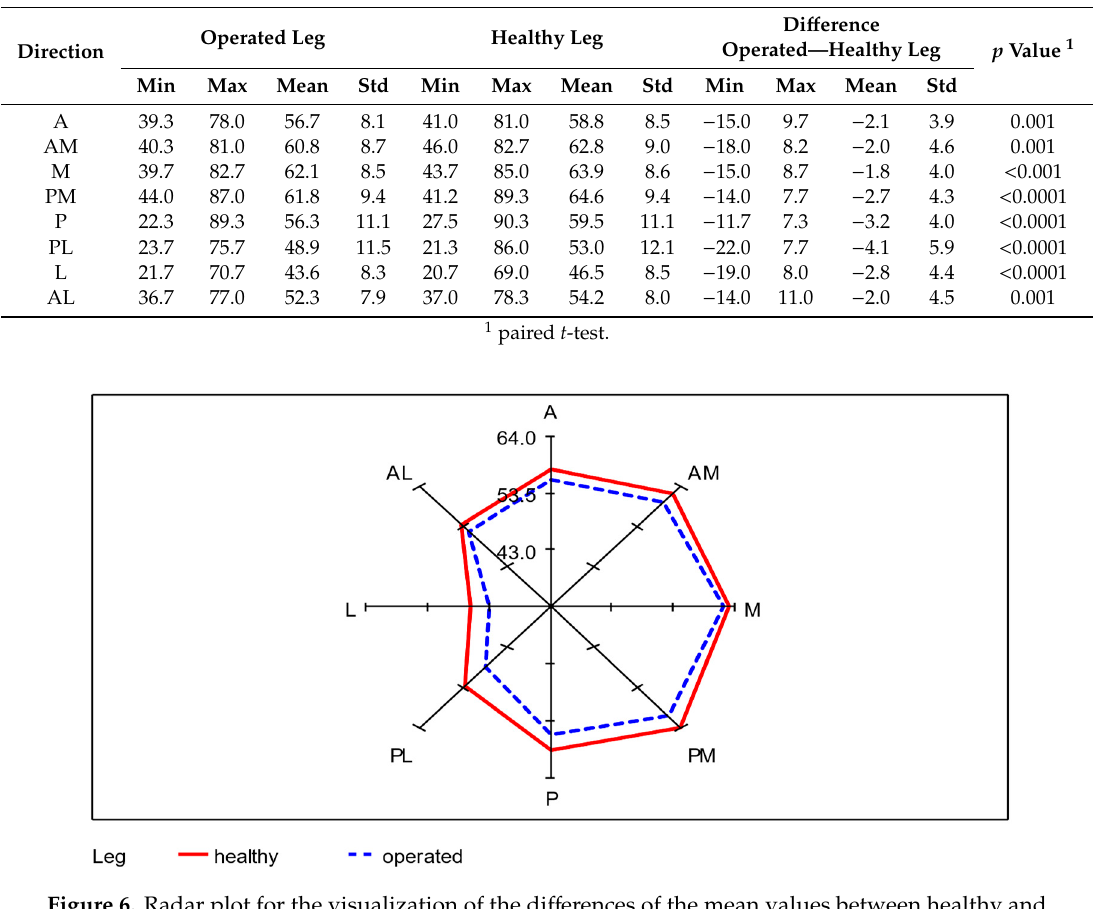
Table 2. Distribution of the Star Excursion Balance Test (SEBT) values (mean of three measurements) (cm), operated versus healthy legs ( n = 61).